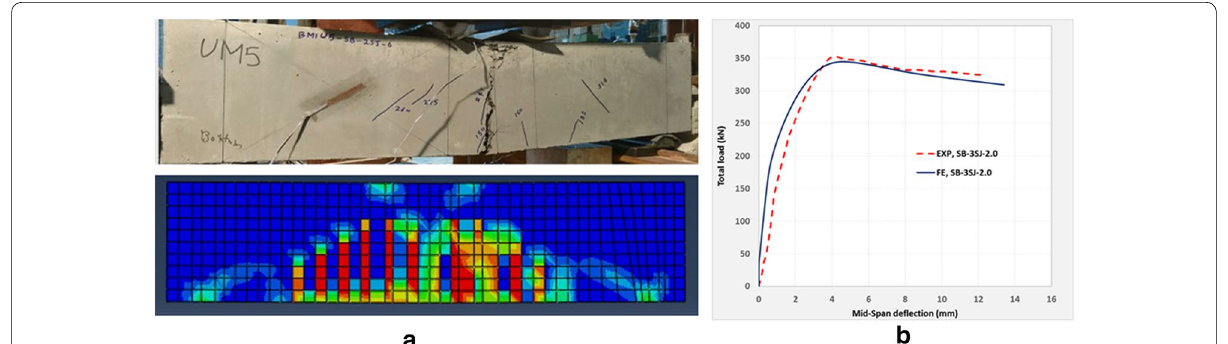
Fig. 25 Retrofitted beam (SB‑3SJ‑2.0): a failure mode, b load–deflection